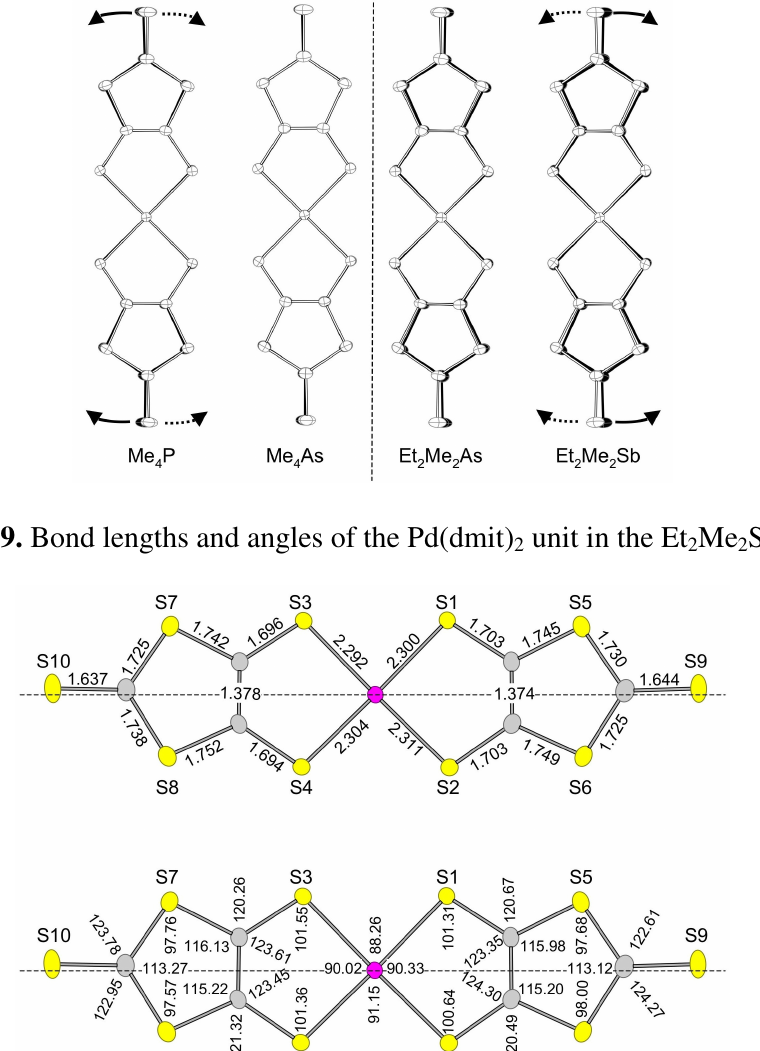
Me Sb salts. 2 2